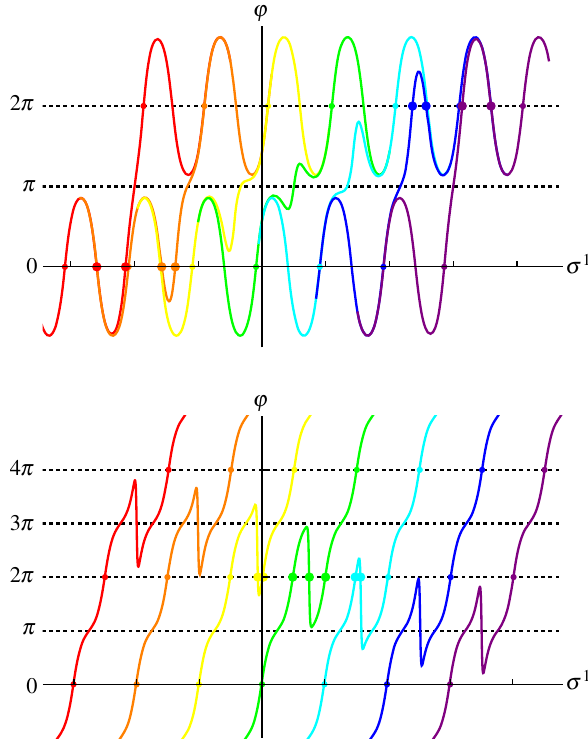
Fig. 22 The time evolution of a kink propagating on a translationally invariant oscillatory background and an antikink propagating on a rotat- ing background being a train of kinks. The dots are positions of spikes. The thick dots are the “interacting” spikes that disappear and reappear in either of the interactions depicted in Fig.